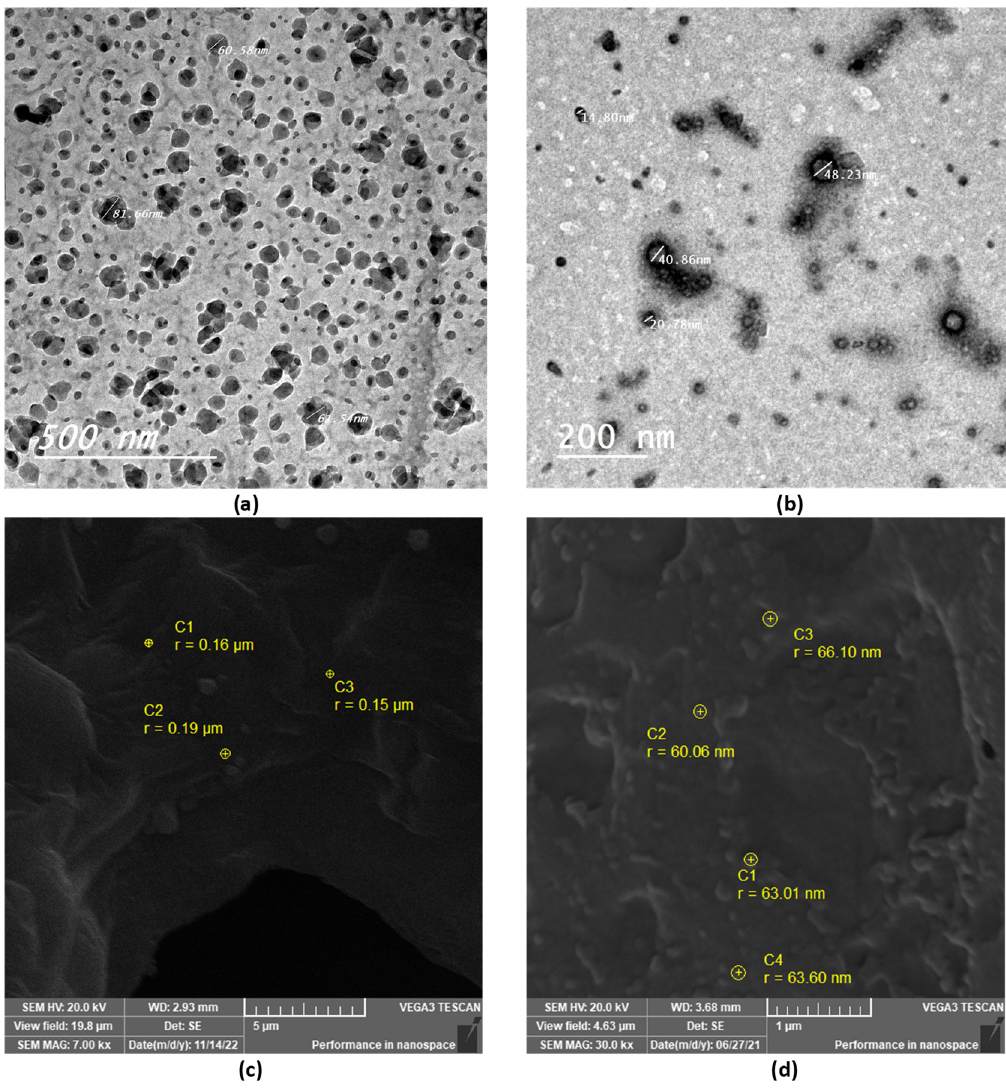
Figure 2. TEM and SEM micrographs of selected thymol-loaded CPNPs; F5 ( a , c ) and C2 ( b , d